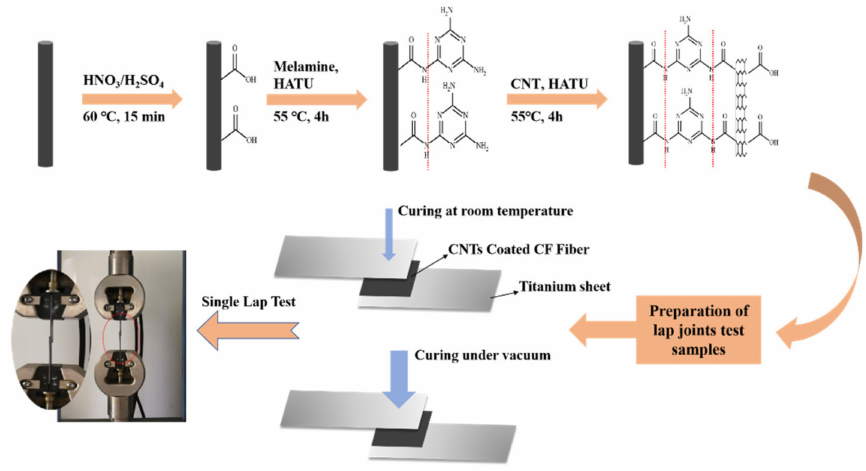
Figure 1. Schematic diagram of the experimental